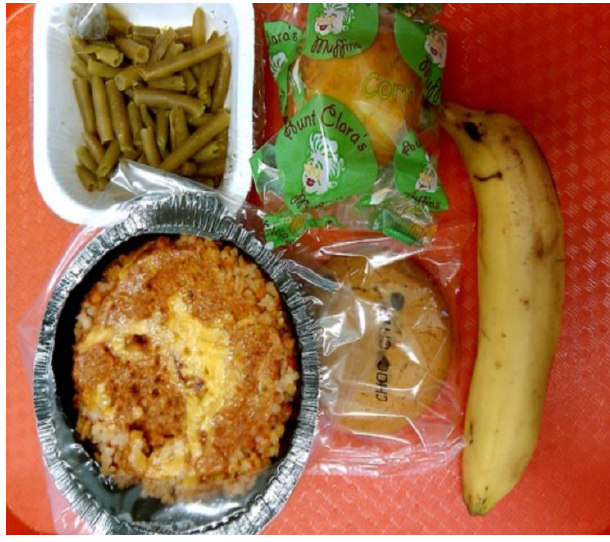
FIGURE 3: A TEX MEX MEAL SERVED IN CPS CAFETERIAS. COURTESY OF SARA WU.